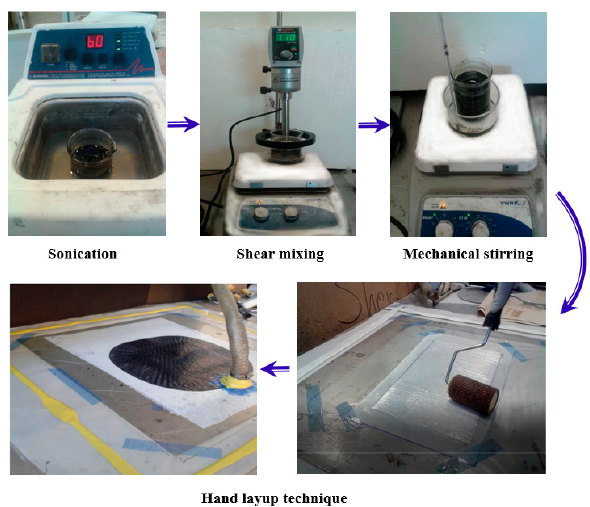
Figure 2. Schematic diagram for fabrication of glass fiber reinforced polymer plates using epoxy-CNFs and epoxy-MWCNTs polymer nanocomposites.